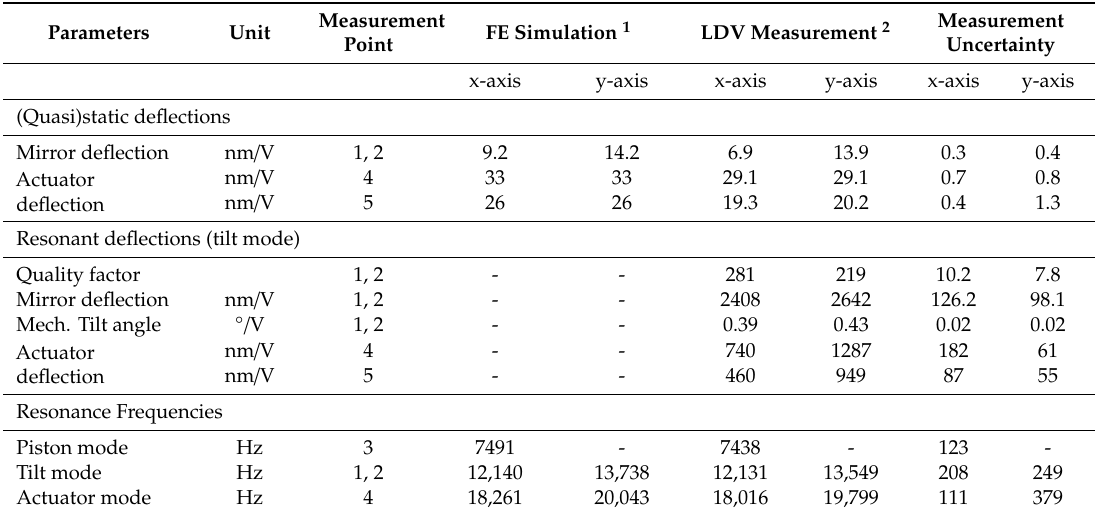
Table 6. Comparison of FE simulation and LDV measurement of Design